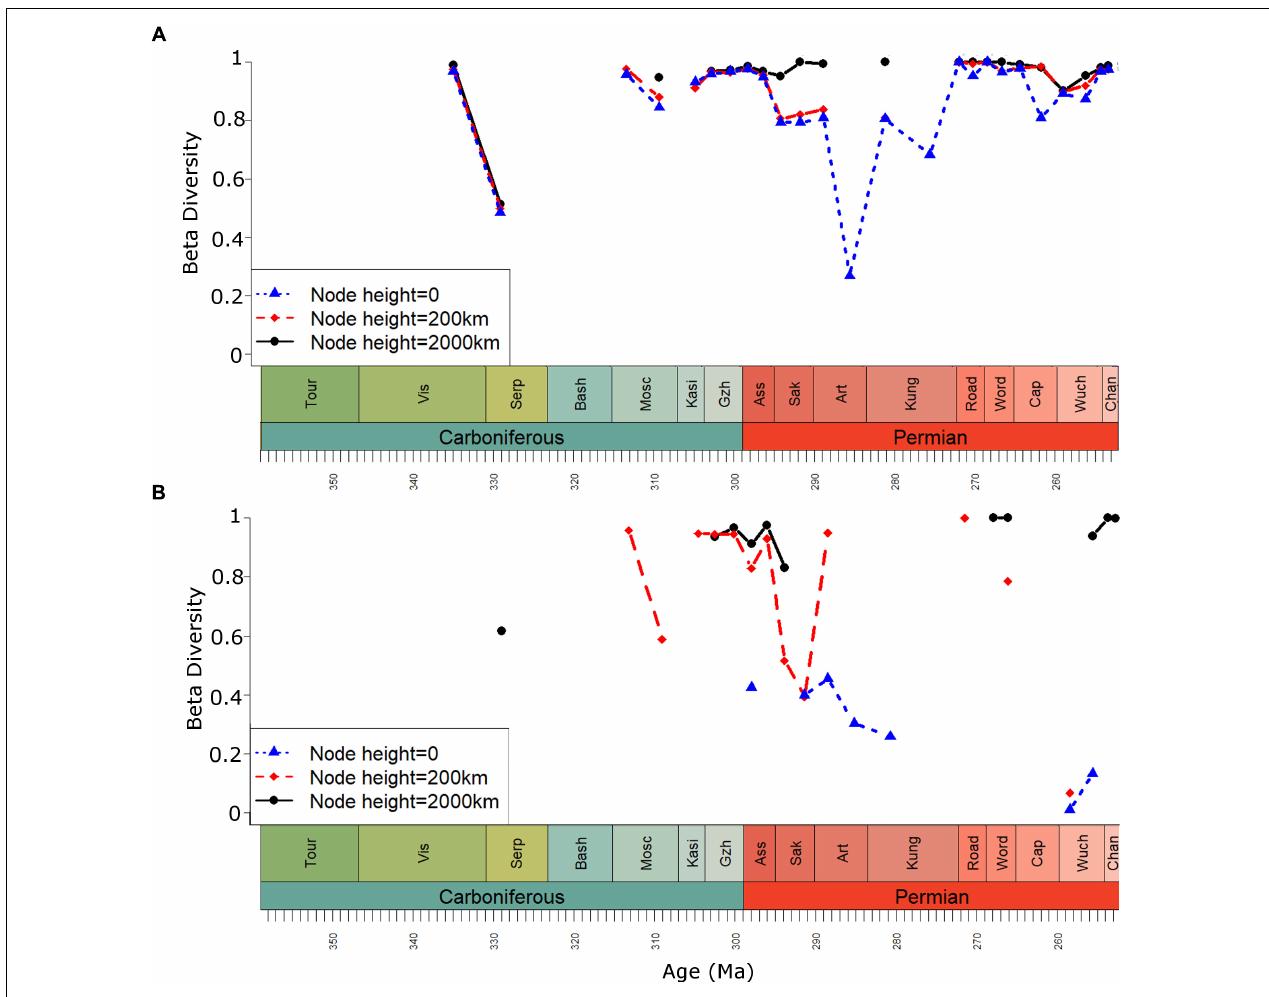
FIGURE 4 | Beta diversity of Palaeozoic tetrapods (mean pairwise taxonomic distance between each bioregion). Bioregions defined at three geographic cluster node heights. (A) No geographic spread subsampling; (B) With geographic spread